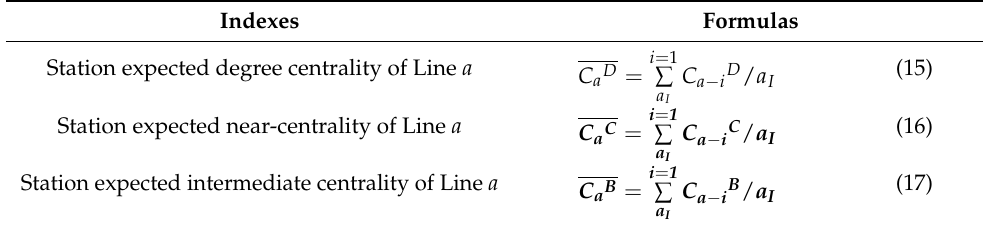
Table 6. Expected centrality of line nodes.